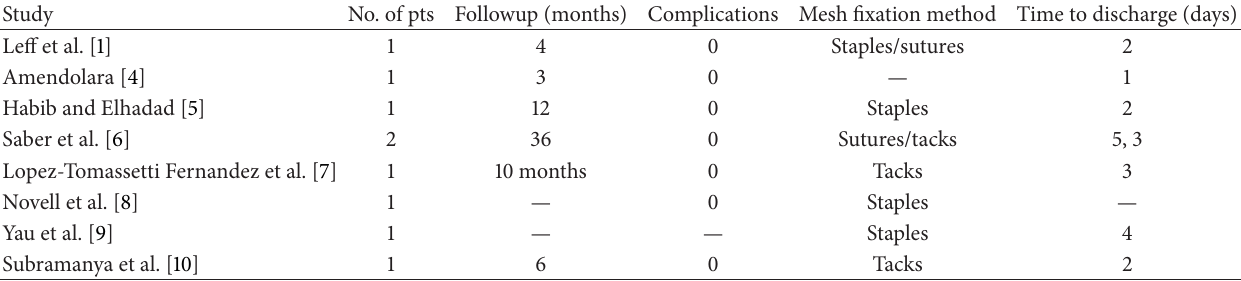
Table 1: Summary of the literature review of patients undergoing laparoscopic repair in an emergent